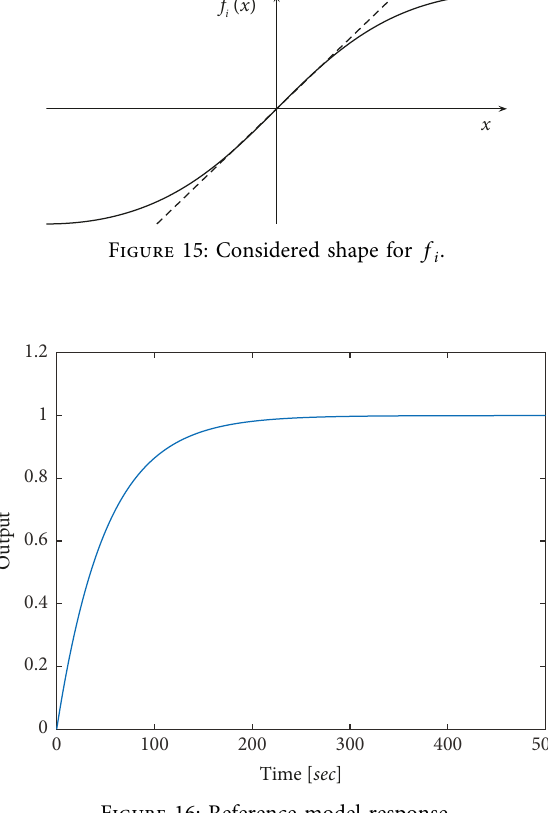
Figure 16: Reference model